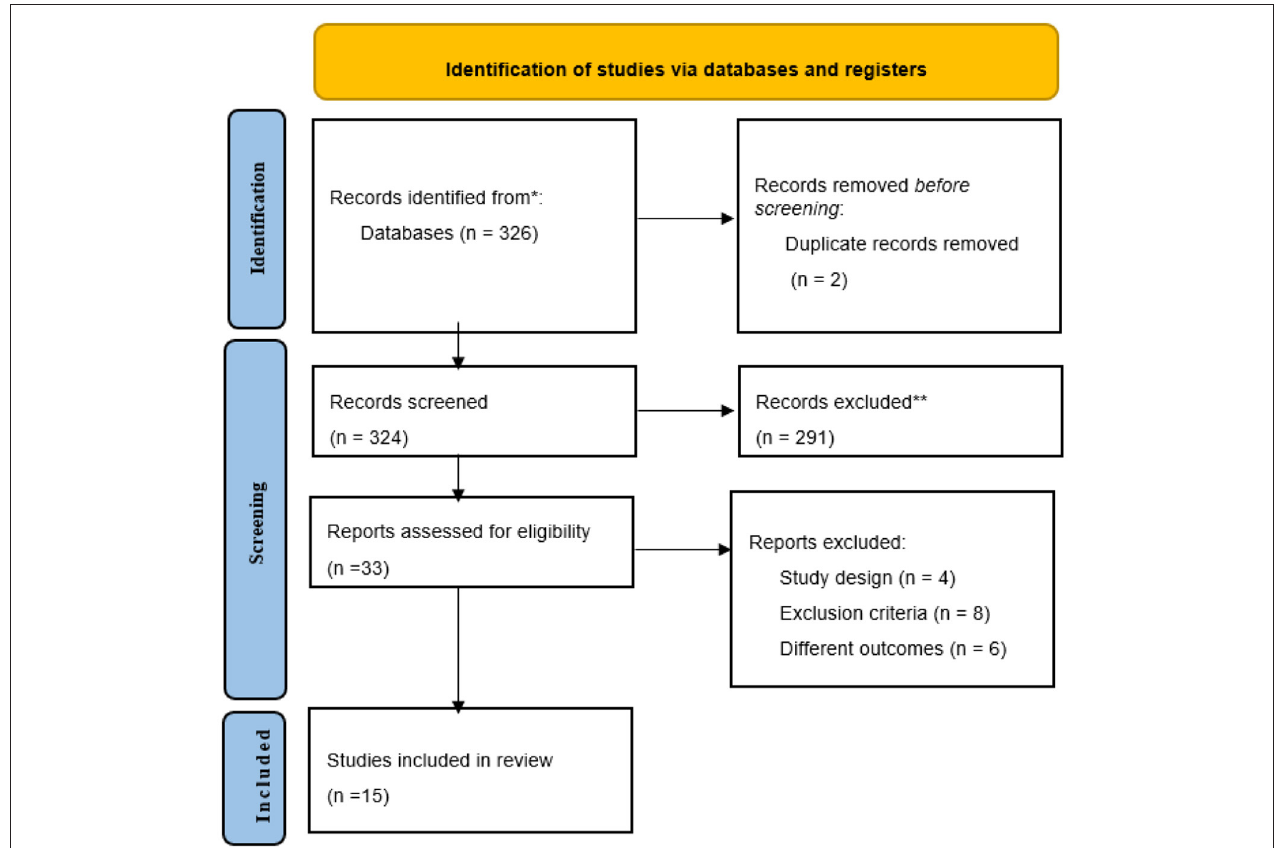
FIGURE 1 | PRISMA 2020 Structured search strategy flow